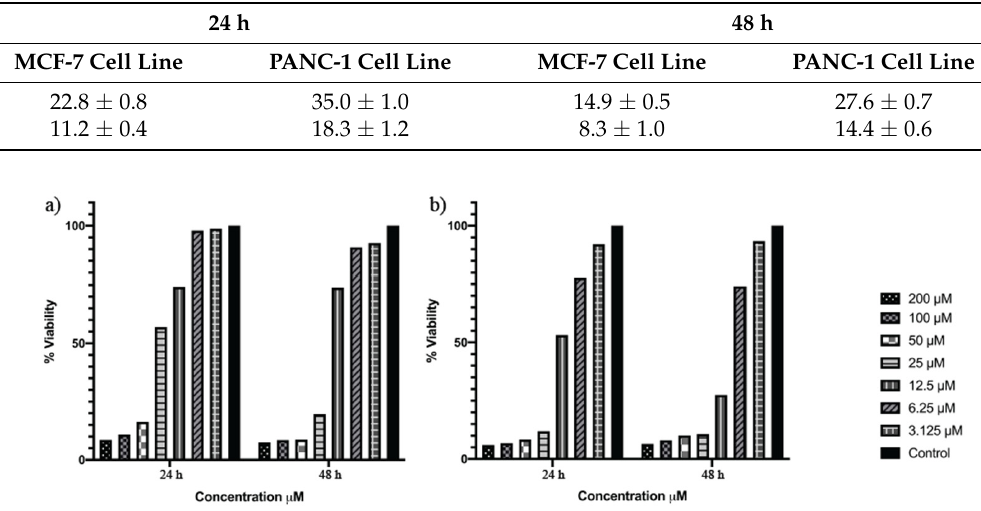
Figure 5. MCF ‐ 7 cells were treated with increasing concentrations of α ‐ aminophosphonate 1 ( a ) and silver complex 3 ( b ) for 24 and 48 h. The viability was determined by metabolic rate using the MTT assay. Absorbance values were measured at 570 nm and normalized against untreated cells.